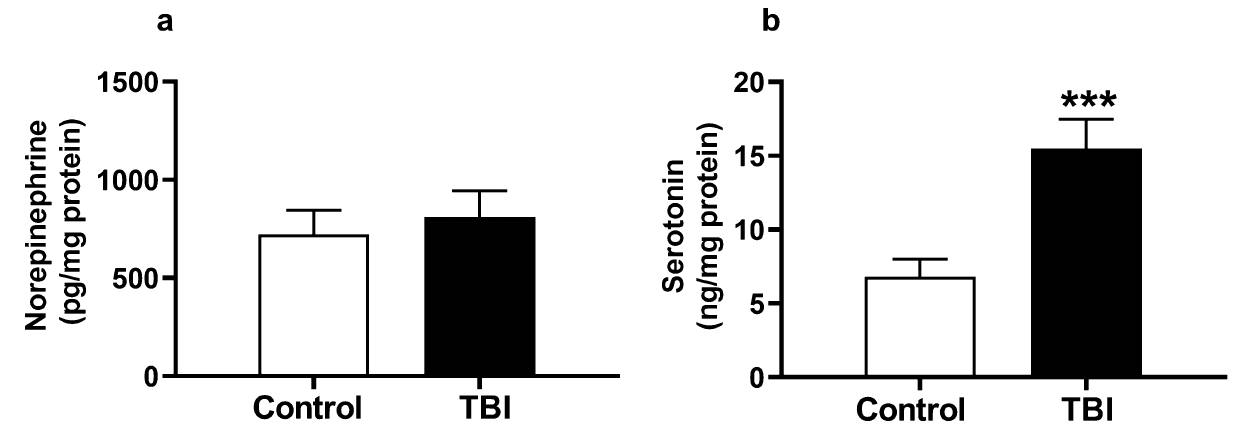
Figure 4. Assessment of spinal levels of the key monoamine pain-related neurotransmitters after mild TBI. Spinal NE and 5-HT levels 4 weeks after TBI at which time the DNIC response had failed were assessed. No significant difference in spinal lumbar NE leves were seen between male TBI and sham mice ( a ). In contrast, there was a significant increase in spinal 5-HT protein levels in TBI compared to control group ( b ). Data were analyzed by two tailed t tests for each protein levels comparision. Error bars: SEM, n = 8/group. p < 0.001 for comparison to control group.